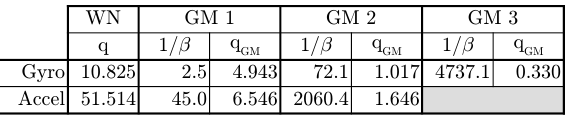
Table 5. Stochastic calibration for the Navchip IMU, the values hold for all the axes.